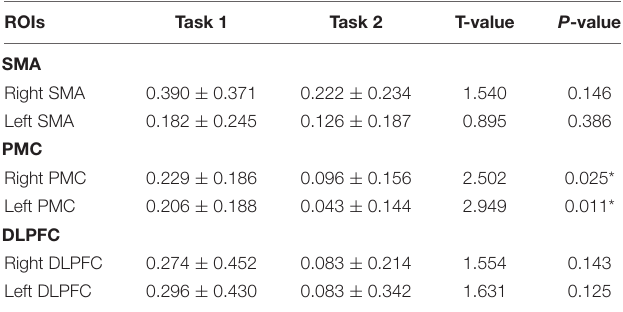
TABLE 3 | The comparison of beta value based on GLM analysis between Task 1 and Task 2 using Paired-Samples T test. ROIs Task 1 Task 2 T-value P -value